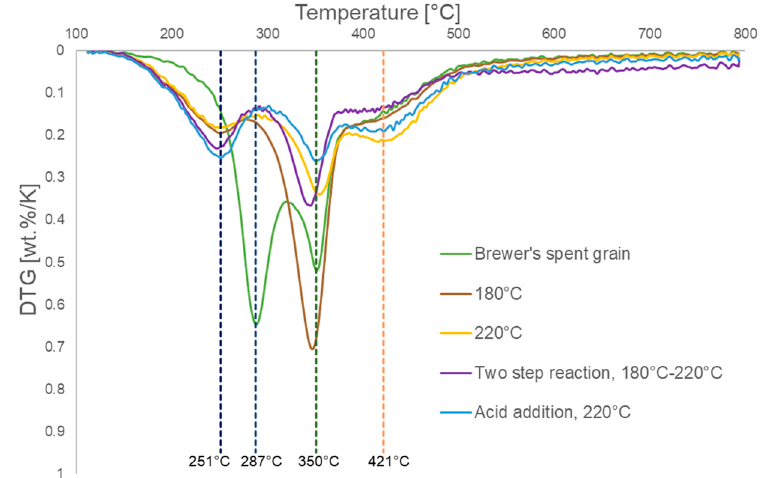
Figure 3. Hydrochar thermal stability at 90% moisture content during 4 h reaction time.